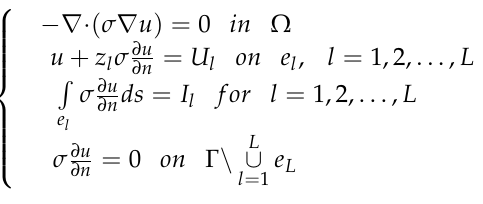
Figure 7. Model of the multiple EIT system converting electrical signals into 3D image pixel-by- pixel.